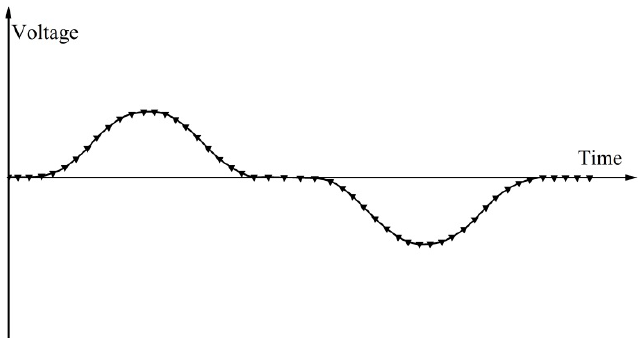
Figure 4. The curve of induction electromotive force of the mathematical